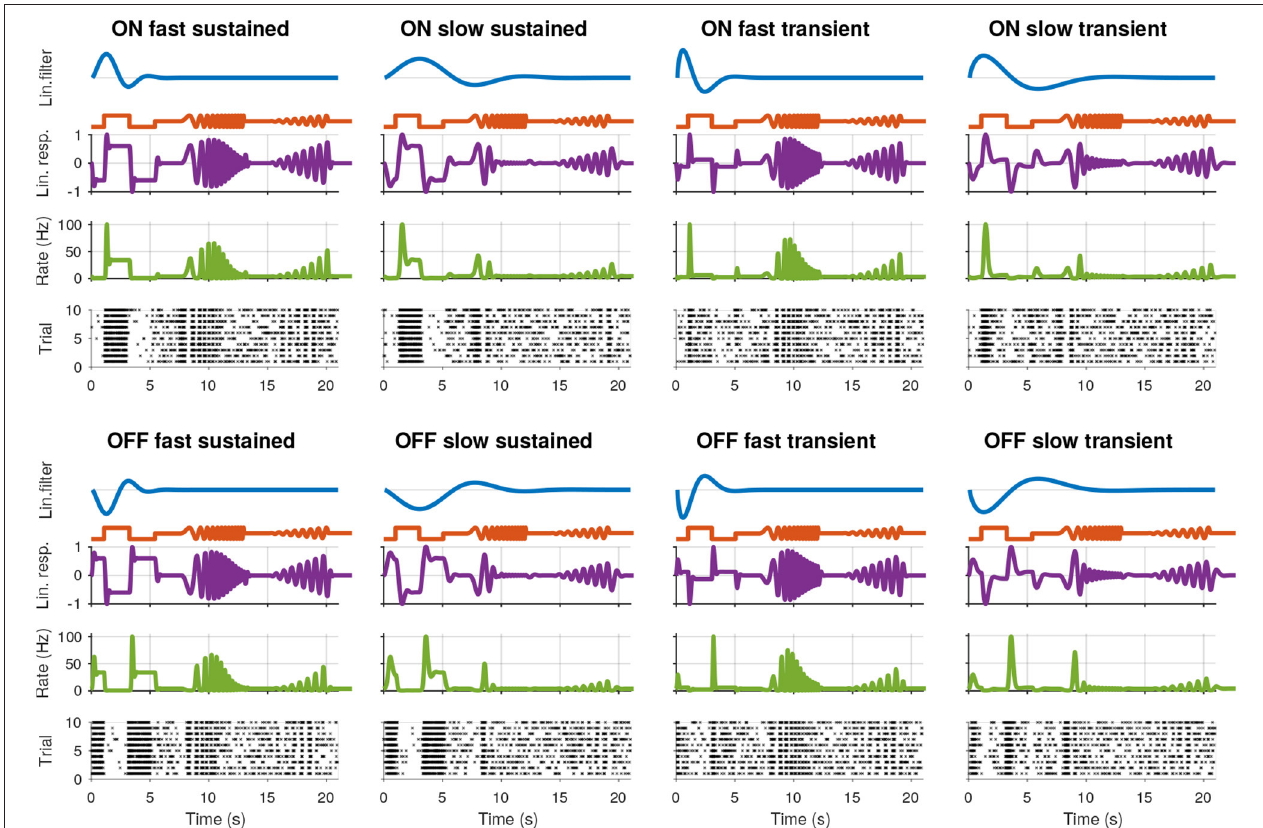
FIGURE 1 | Synthetic retinal ganglion cell response models. For each of the eight cell types, rows from top to bottom: (i) the linear receptive field (RF) of the cell; (ii) the stimulus; (iii) the linear response of the cell, computed by convolving the RF with the stimulus; (iv) the spike rate obtained by passing the linear response through a non-linear function; and (v) the spike raster generated using a Poisson process.